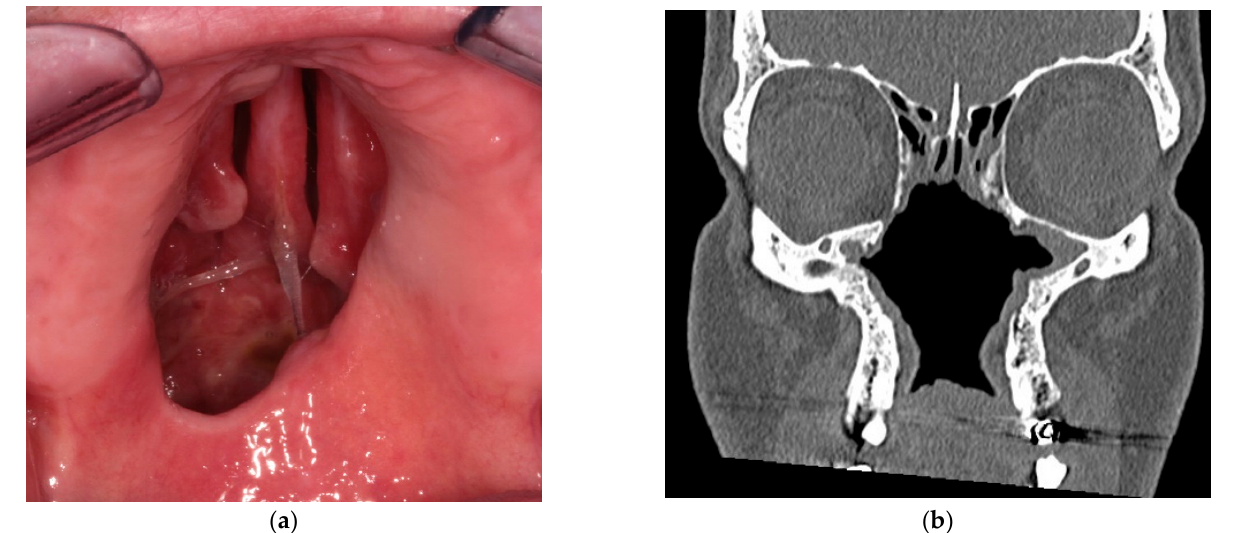
Figure 3. Patient 3: ( a ) Hard and soft palatal perforation at oroscopy. ( b ) A CT scan showing massive erosion of the midline structures, with the destruction of nasal septum, turbinates, and palate.